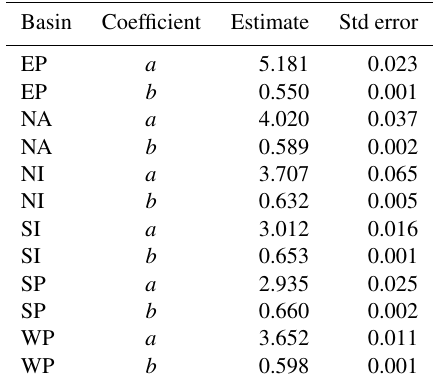
Table A2. Wind pressure relationship coefficients (i.e., V = a ((cid:49)P) b , a in hPa − 1 ms − 1